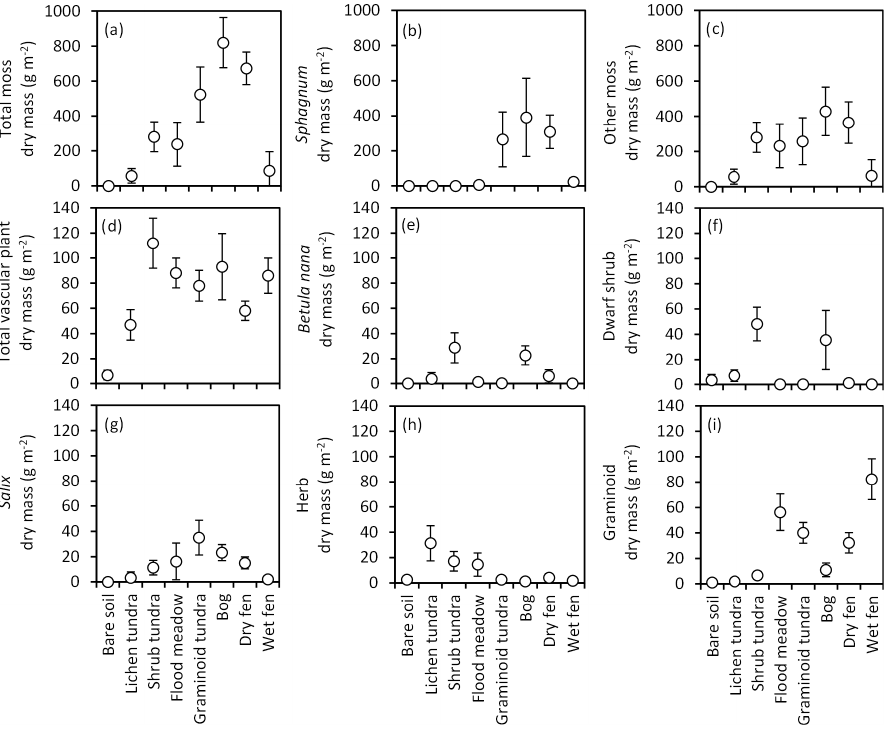
Figure 6. Biomass (mean ± 85% CI) of (a) all mosses, (b) Sphagnum , (c) mosses excluding Sphagnum , (d) all vascular plants, (e) Betula nana , (f) dwarf shrubs, (g) Salix , (h) herbs and (i) graminoids in late July (ca. 360 DD) in the land cover types of Tiksi tundra (arranged in order of increasing soil water concentration). Table 2. The number of study plots ( n ), the mean distance of plots (within-type delta) within land cover types (LCTs), and the T -statistic and P values of the mean distance of LCTs (all derived using the multi-response permutation procedure, MRPP) when the analysis is based on the presence/absence data of dicotyledonous plants (lower-left triangle) or plant functional group biomasses and soil parameters (upper-right triangle). Significant P values are highlighted in